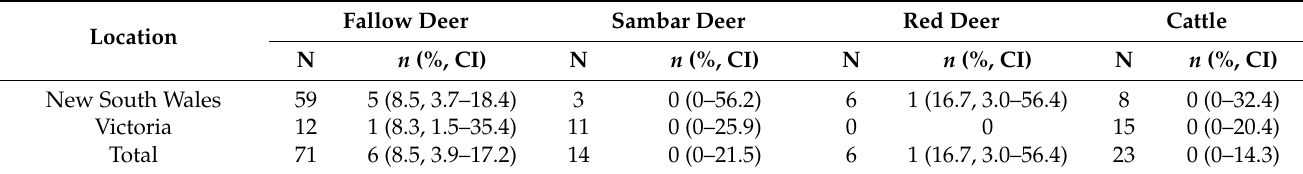
Table 3. Prevalence of deer/bopivirus in deer and cattle from south-eastern Australia. Fallow Location